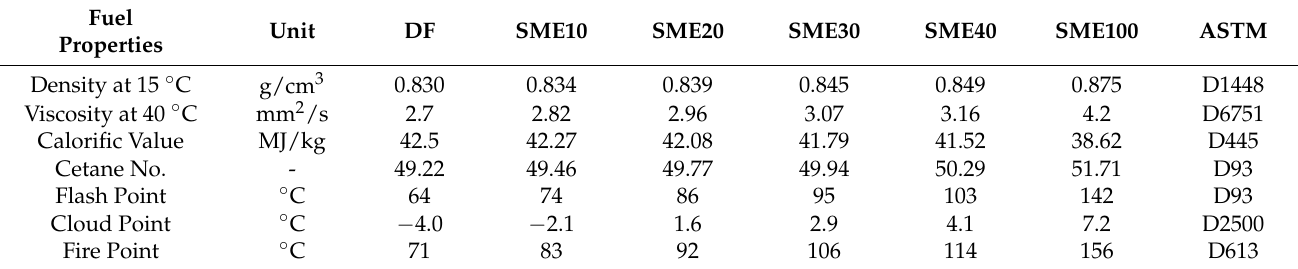
Table 2. Fuel properties.